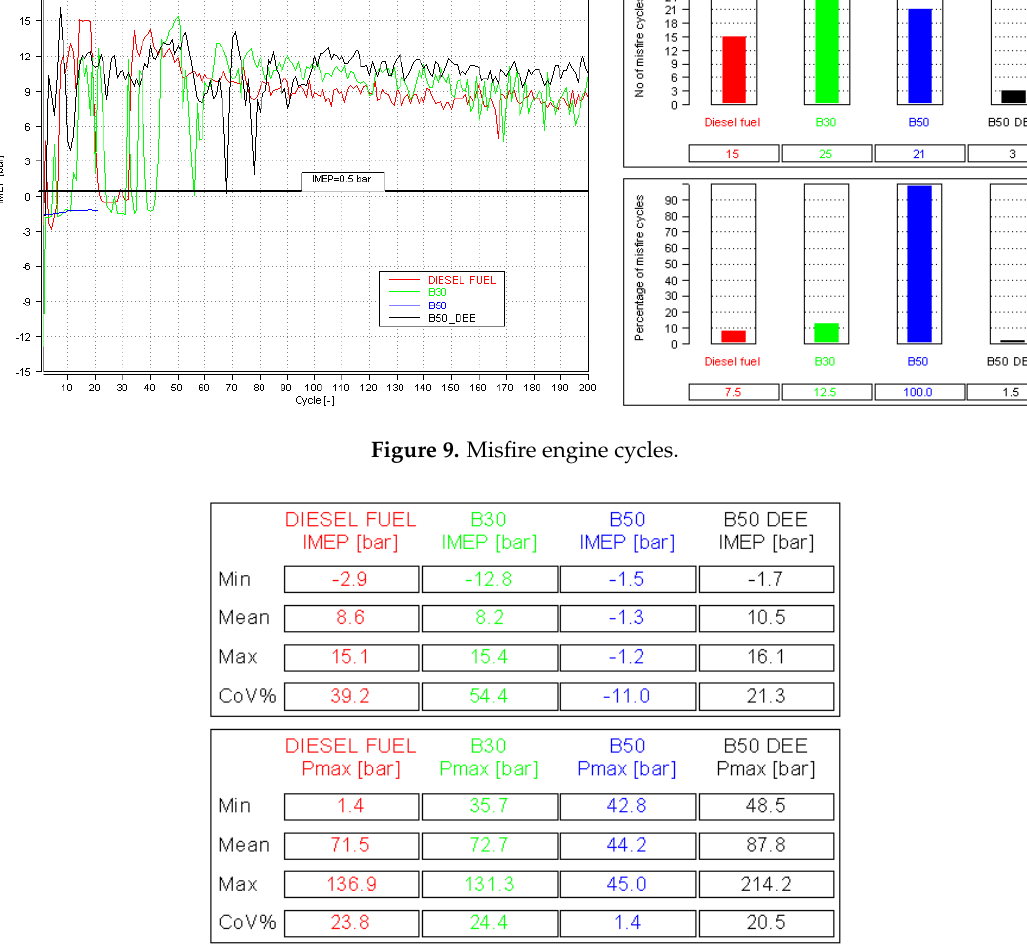
Figure 10. Cyclic dispersion over the first 200 engine cycles.